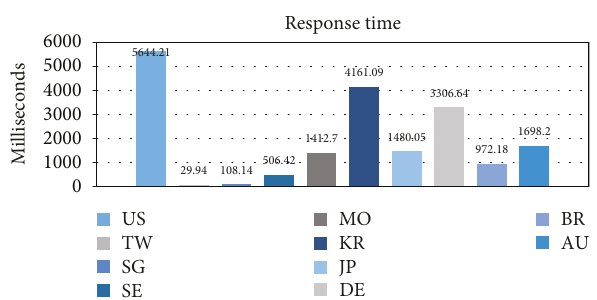
Figure 6: Geographical measurements of blanket mode (processing